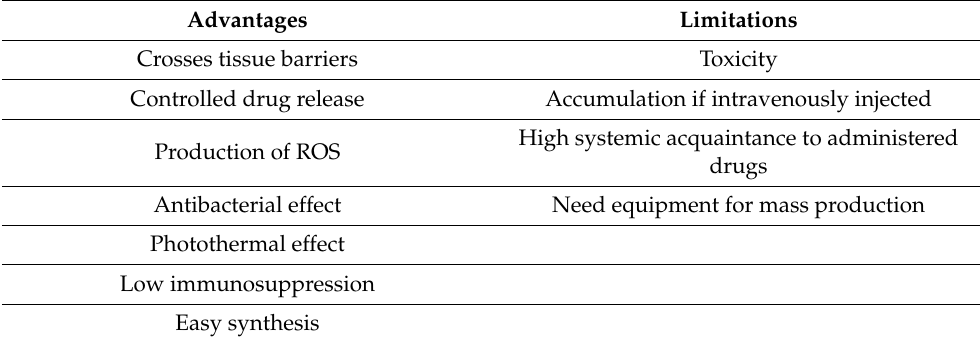
Table 3. Advantages and limitations of antibacterial Ag and Au